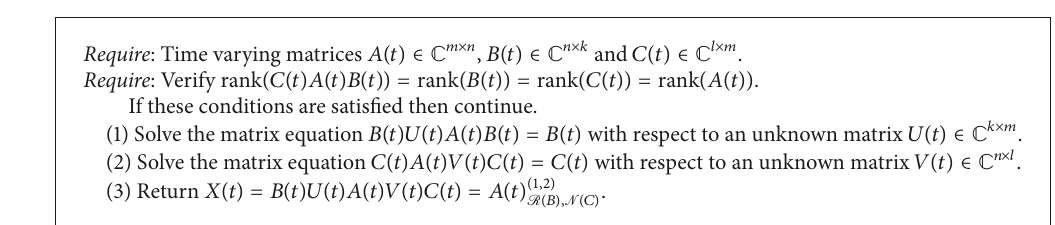
Algorithm 7: Computing a {1, 2} -inverse with the prescribed null space.